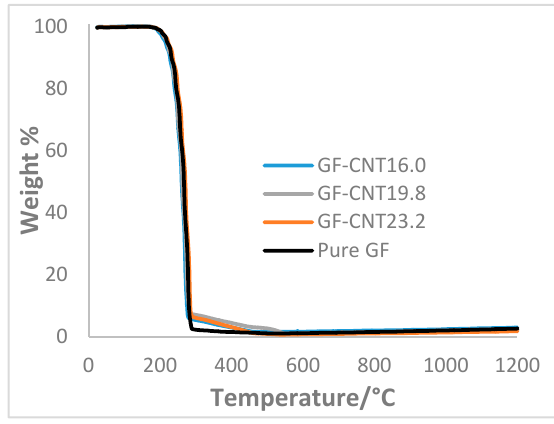
Figure 2. Thermogravimetric analysis (TGA) of GF-CNT x.